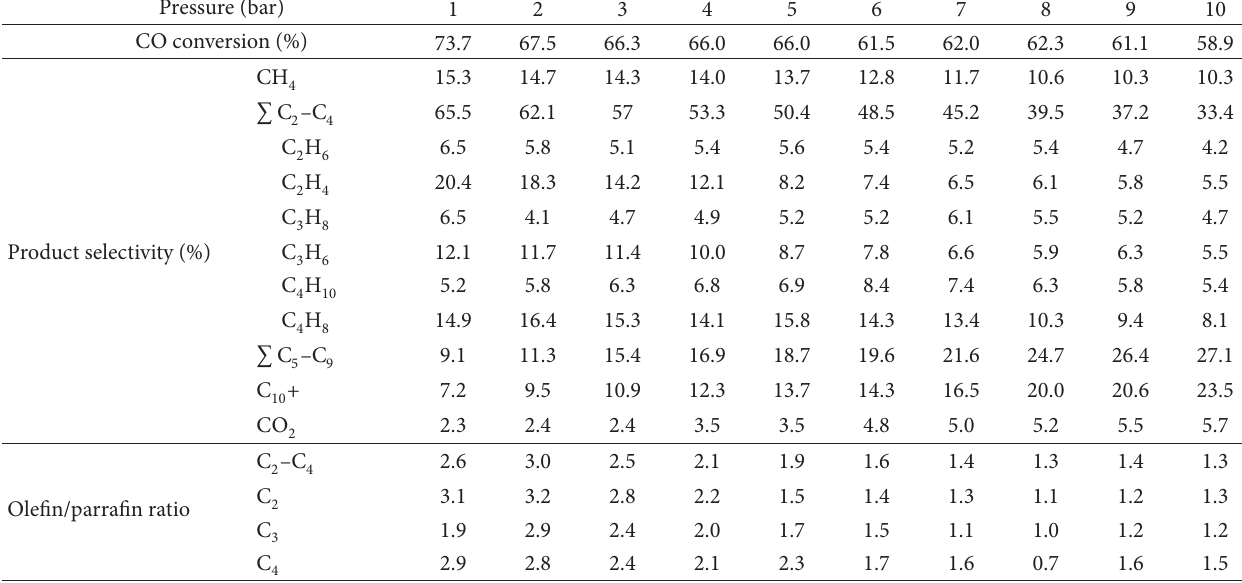
T 7: Effect of different total reaction pressure on the catalytic performance of